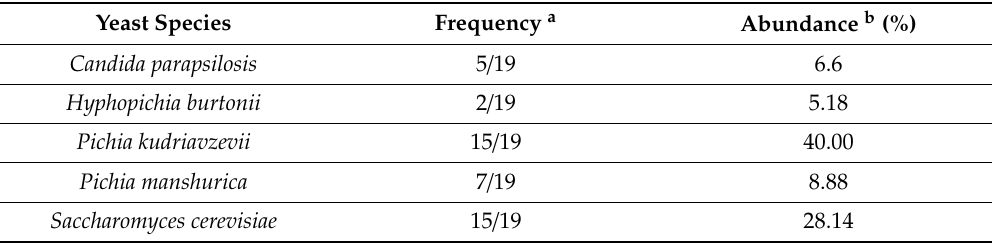
Table 3. Frequency and abundance of yeast species isolated from Criollo Colombian cocoa samples, fermented for 6 days and sun dried for 3 to 6